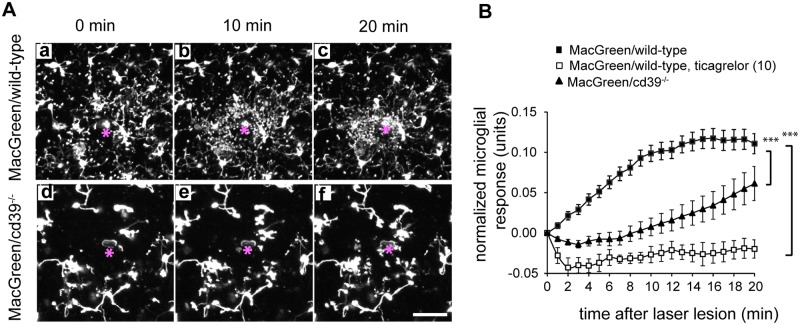
Activity of CD39 is required for directional movement of microglia processes towards a laser lesion in acute brain slices.(A) Movement of microglia processes in acute brain slices of MacGreen/wild-type or MacGreen/cd39-/- mice expressing EGFP under the control of colony stimulating factor 1 receptor promoter (CSF1R) was studied using two-photon time-lapse microscopy. A laser lesion (marked by asterisk) was set, 60 μm-thick Z-stacks with a step size of 3 μm covering a field of 307 x 307 μm were acquired every minute. The extension of the processes toward the laser lesion was strongly attenuated in cd39-/- mice. Images show maximum intensity projections of 60 μm-thick Z-stacks. Scale bar 20 μm. (B). Quantification of laser lesion in MacGreen/wild-type (black squares) and MacGreen/cd39-/- mice (black triangles) over a 20-min time course is shown (n = 8 mice per genotype, 3 slices per an individual mouse), and data are shown as the mean values and standard error of mean. P2Y12 receptor inhibitor ticagrelor (10 μM, white squares) abrogated process movement towards a laser lesion in slices of wild-type mice; slices were pre-incubated with ticagrelor for 20 min before the laser lesion was set. Subsequently, microglial process movement towards the laser lesion was recorded in the presence of ticagrelor. Normalized microglial responses measured 20 min after the laser lesion were compared; significant difference was tested by one-way ANOVA, *** denotes p < 0.001.